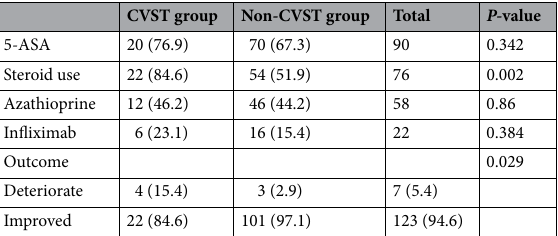
Table 3. Medication history of IBD cohort and outcome of patients. Disease outcome included both IBD and CVST.